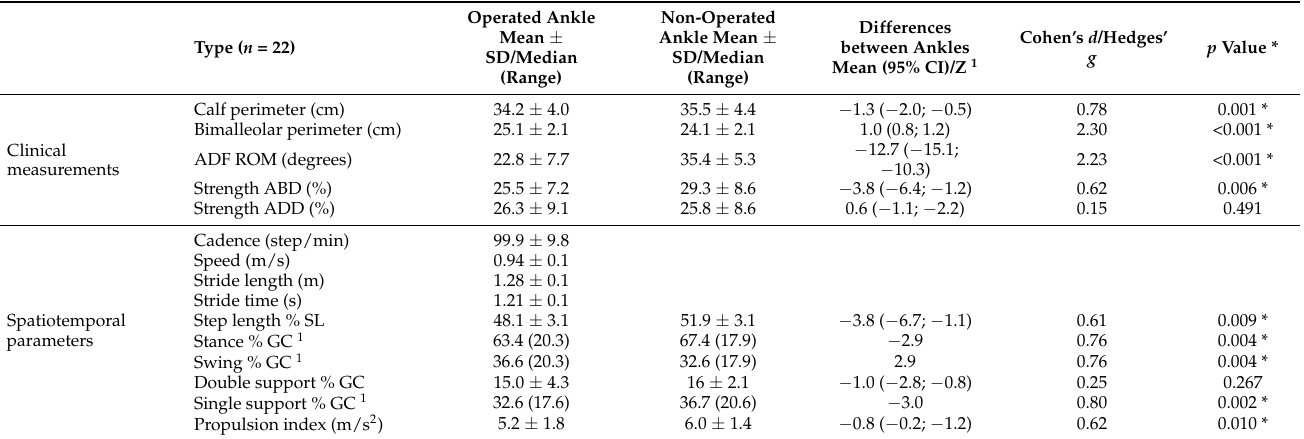
Table 2. Difference between the operated and non-operated ankle in clinical measurements, spatial– temporal gait parameters, and dynamic plantar